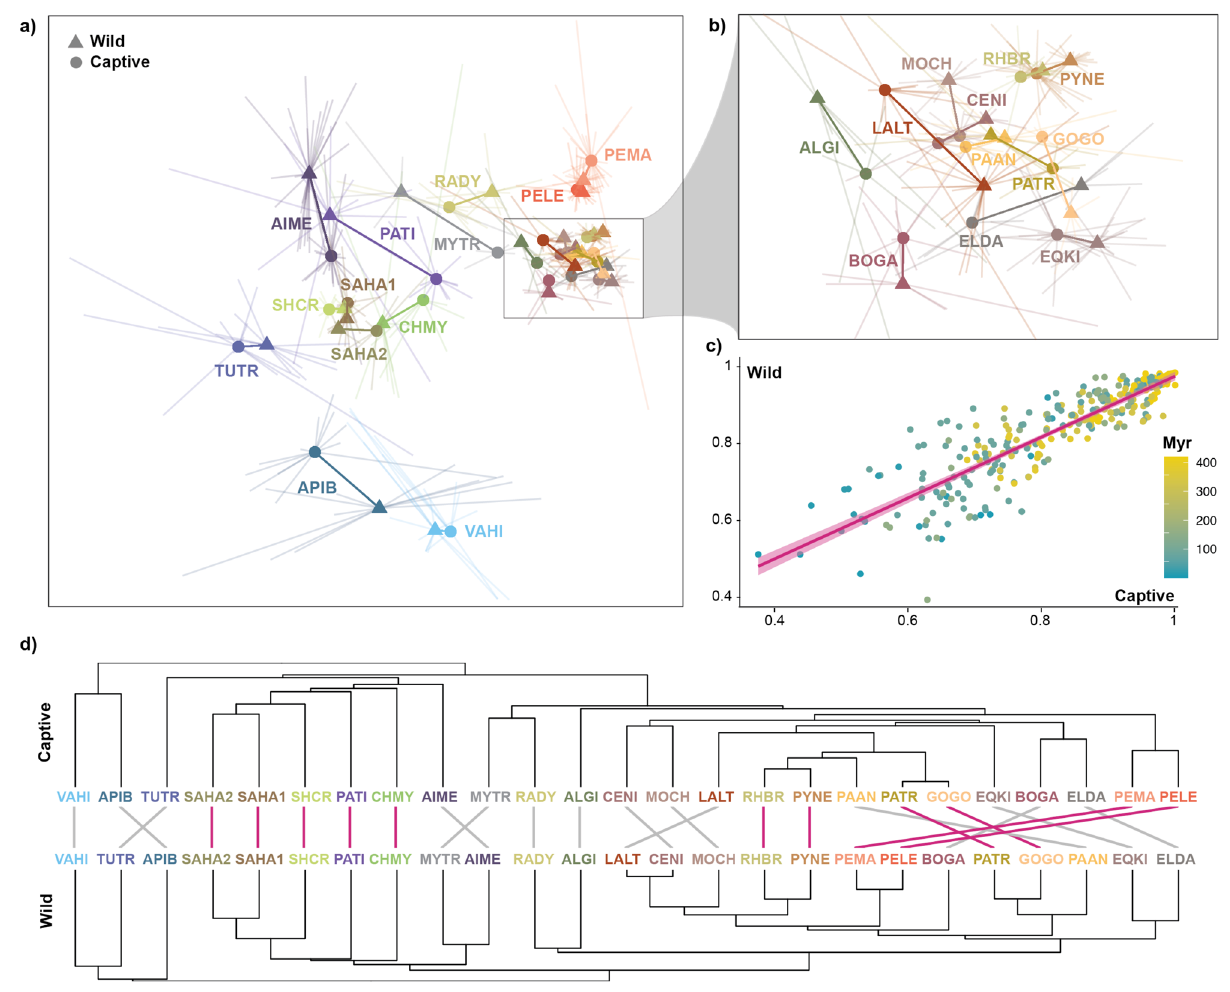
Figure 4. Compositional differences of the gut microbiota between wild and captive animals. ( a ) NMDS plot of the gut microbiota composition between wild and captive animals coloured by host species. Triangles and circles linked by solid lines indicate the centroids of the gut microbiota composition in wild and captive animals, respectively, as defined by the individual data (outer edges of the thin lines) of each species. ( b ) Zoomed image of the NMDS plot to improve the visualisation of compositionally similar primates and artiodactylans. ( c ) Correlation plot between pairwise compositional differences of the gut microbiota between host species as calculated based on wild (Y axis) and captive (X axis) specimens. Colours of the dots indicate the evolutionary distance (in millions of years) between compared hosts. ( d ) Topological differences of the hierarchical clustering of species-level gut microbiota based on captive and wild animals. Common subtrees between captive and wild cladograms are highlighted by pink connecting lines. Abbreviations are explained in Fig.